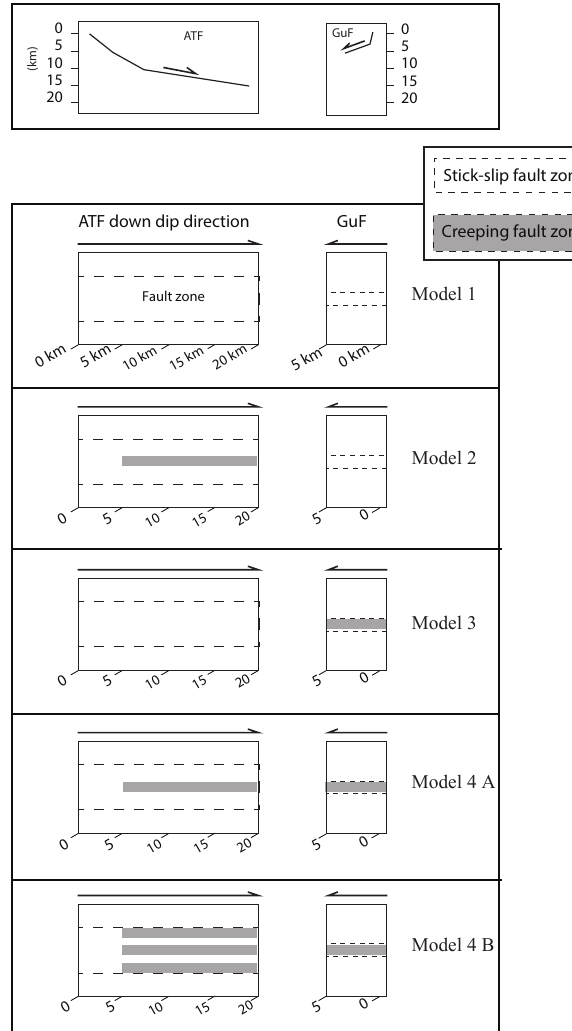
Figure 3. The different model configurations used to compute the interseismic stress build-up. First line: schematic sketch of the ATF (left column) and GuF fault zone (right column). The dashed ar- eas represent the ATF and GuF zones. The creeping deformation is modelled in the grey